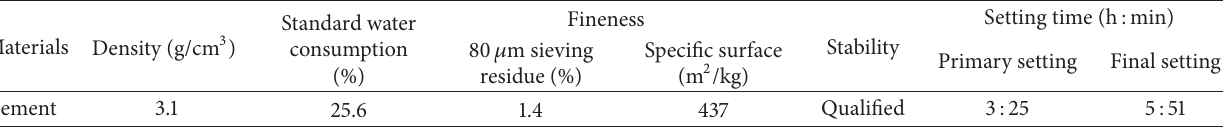
Table 1: Physical properties of cement (wt.%).